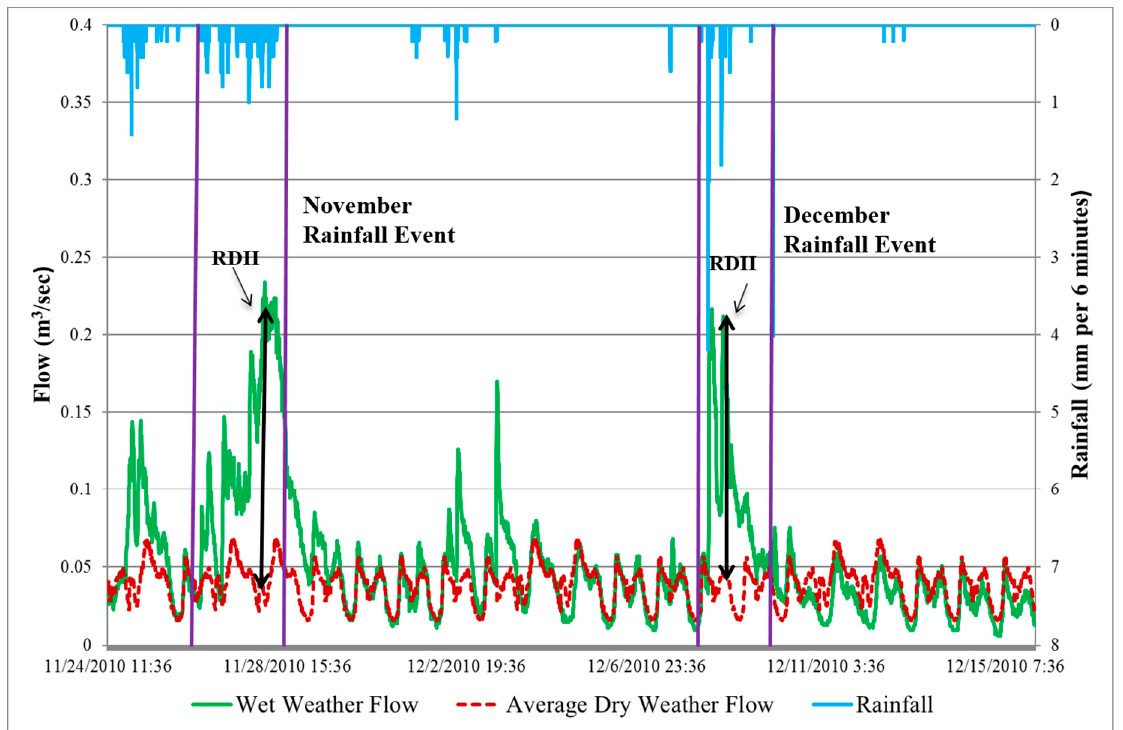
Figure 3. The RDII hydrograph determined using the Hydrograph Decomposition method.